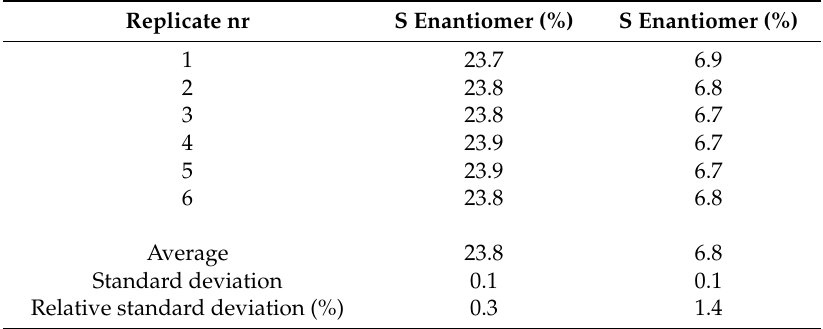
Table 2. Repeatability of the quantitation of the minor enantiomer at two different concentrations. NMR spectra recorded at 260